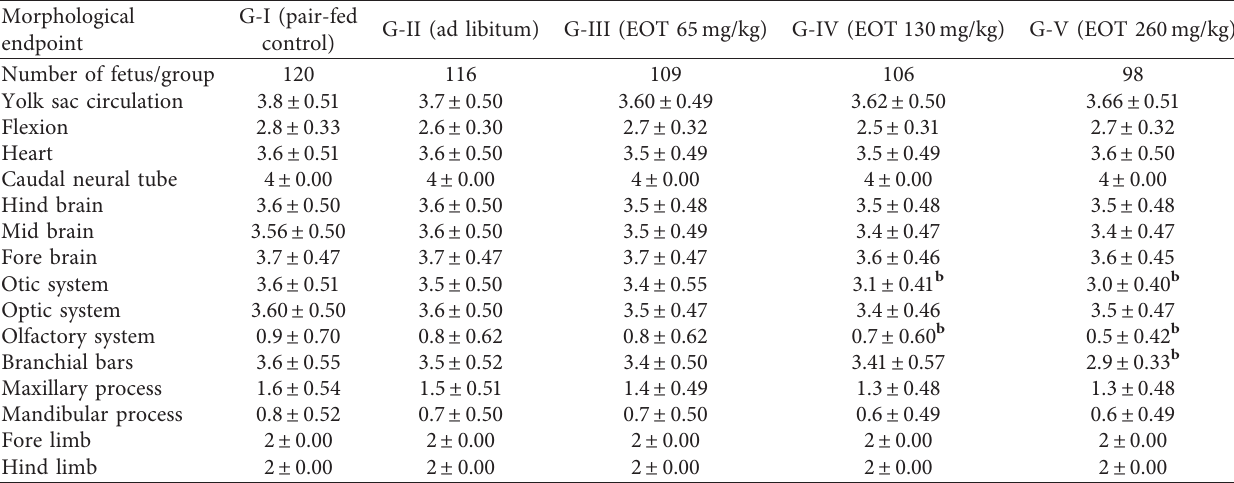
Table 3: In vivo development of the rat embryo following treatment with administration of essential oil extract of Thymus schimperi : day 12 experiment.